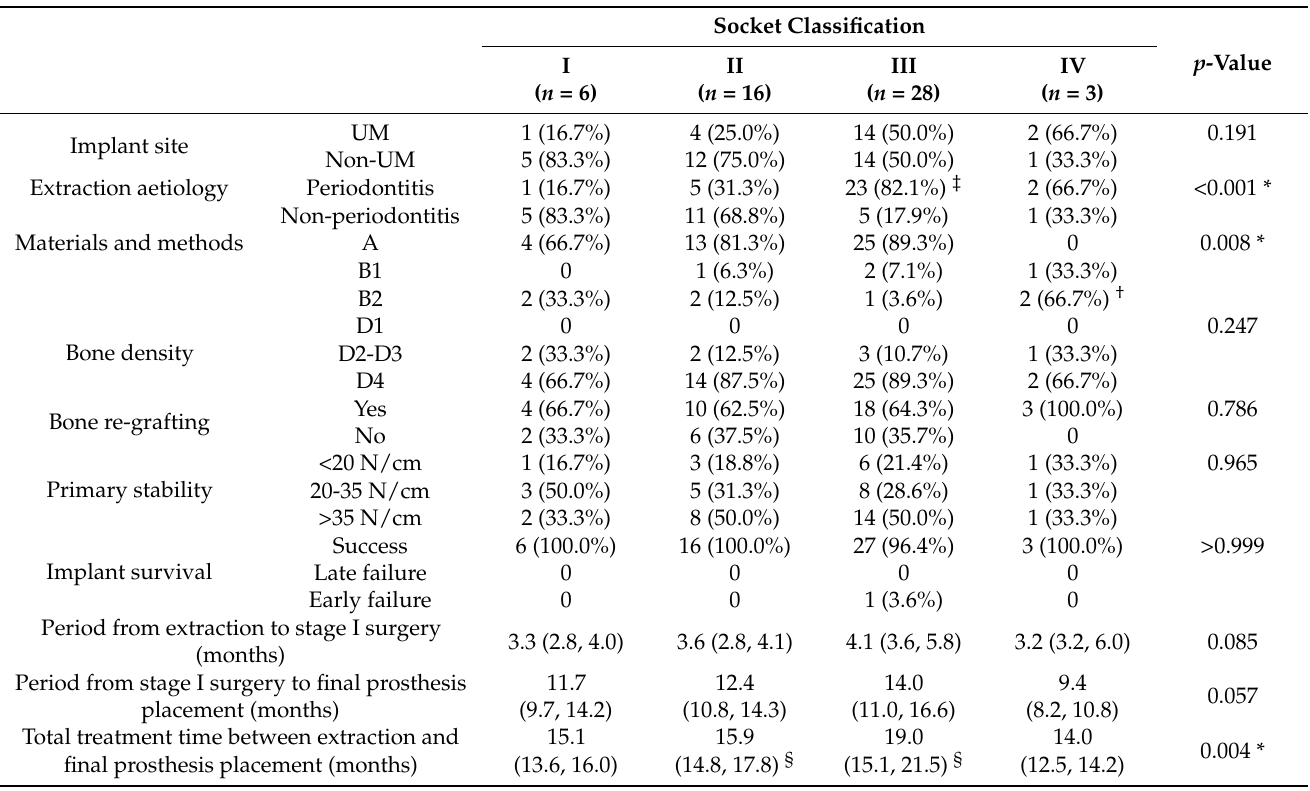
Table 2. Association of socket classification and implant site development for maxillary implants with flapless ridge preservation.